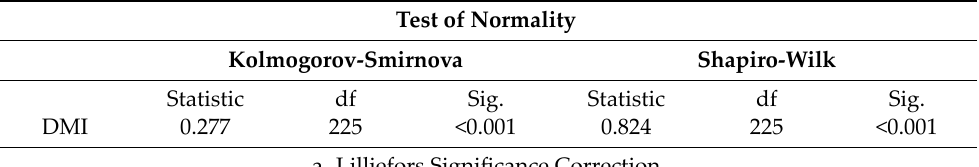
Table 5. Data distribution of DMI and content topic